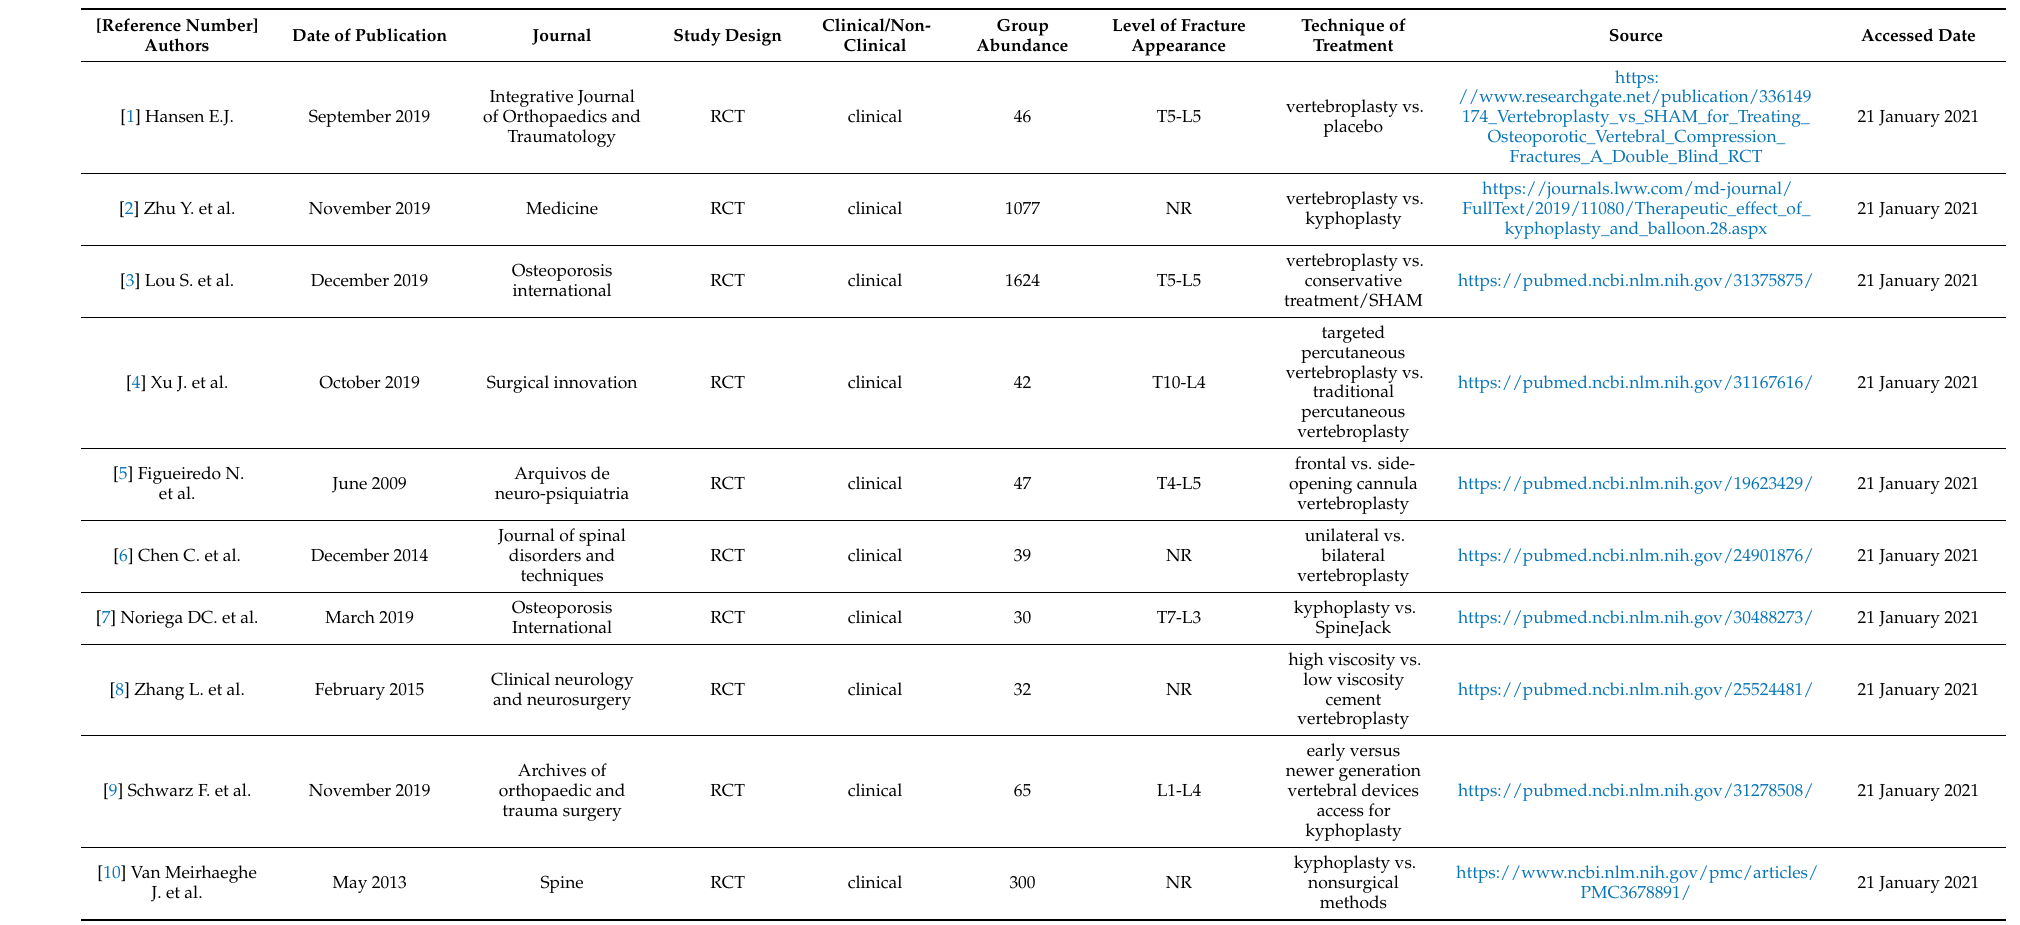
Table 1. Characteristics of eligible